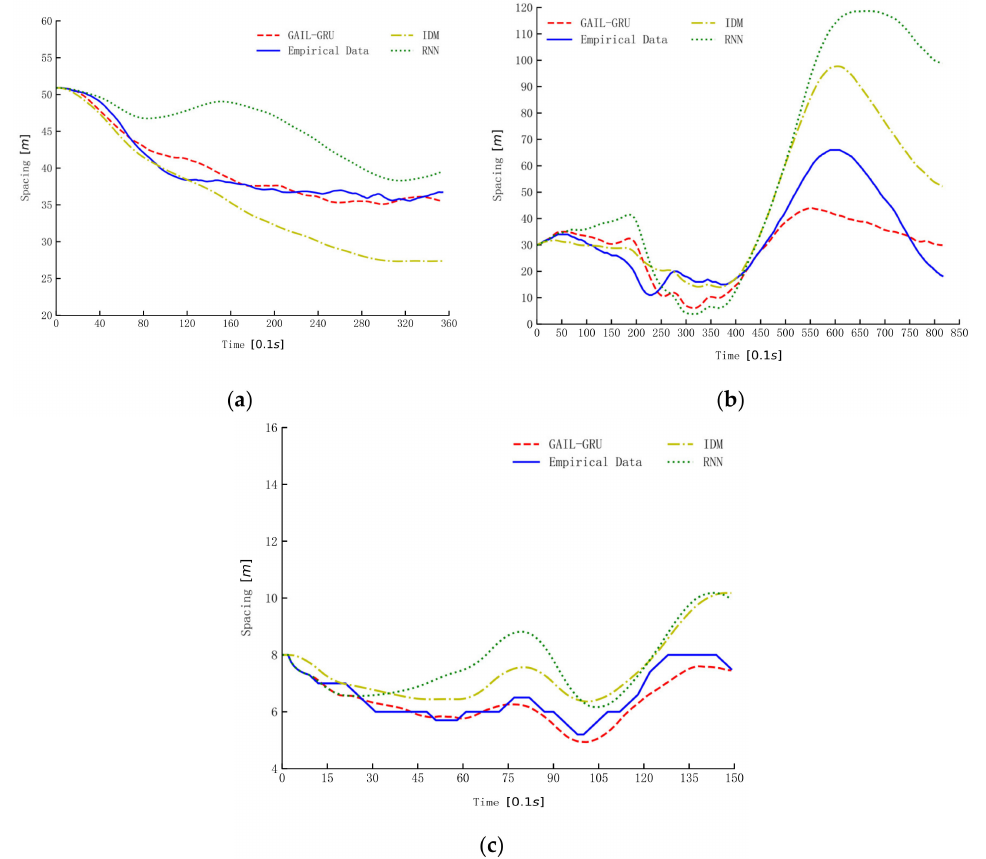
Figure 14. The simulation of spacing by di ff erent models. ( a – c ) are the simulation results of spacing for the three car-following periods randomly selected from the